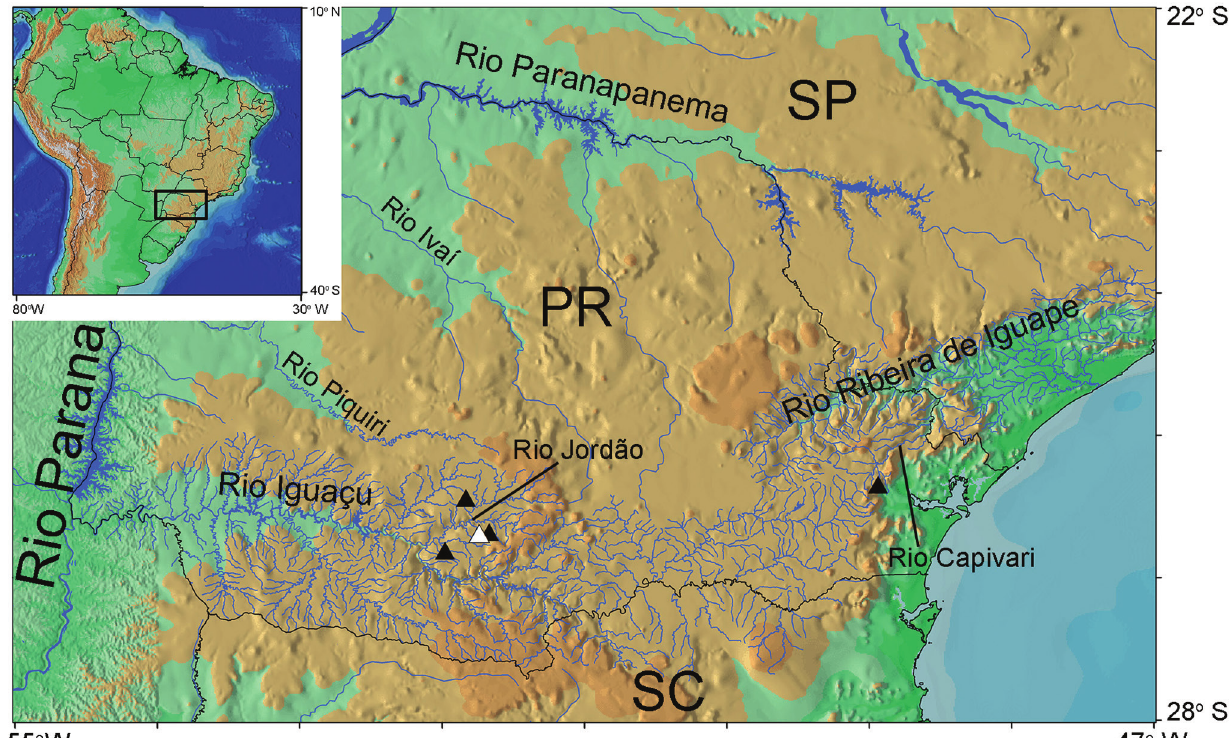
Fig. 2. Geographic distribution of Characidium travassosi . White triangle = type locality; black triangles = additional